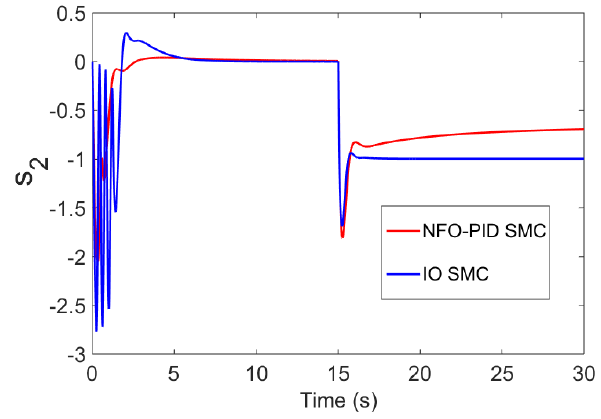
Figure 7. Curves of first-layer sliding mode surfaces s 2.